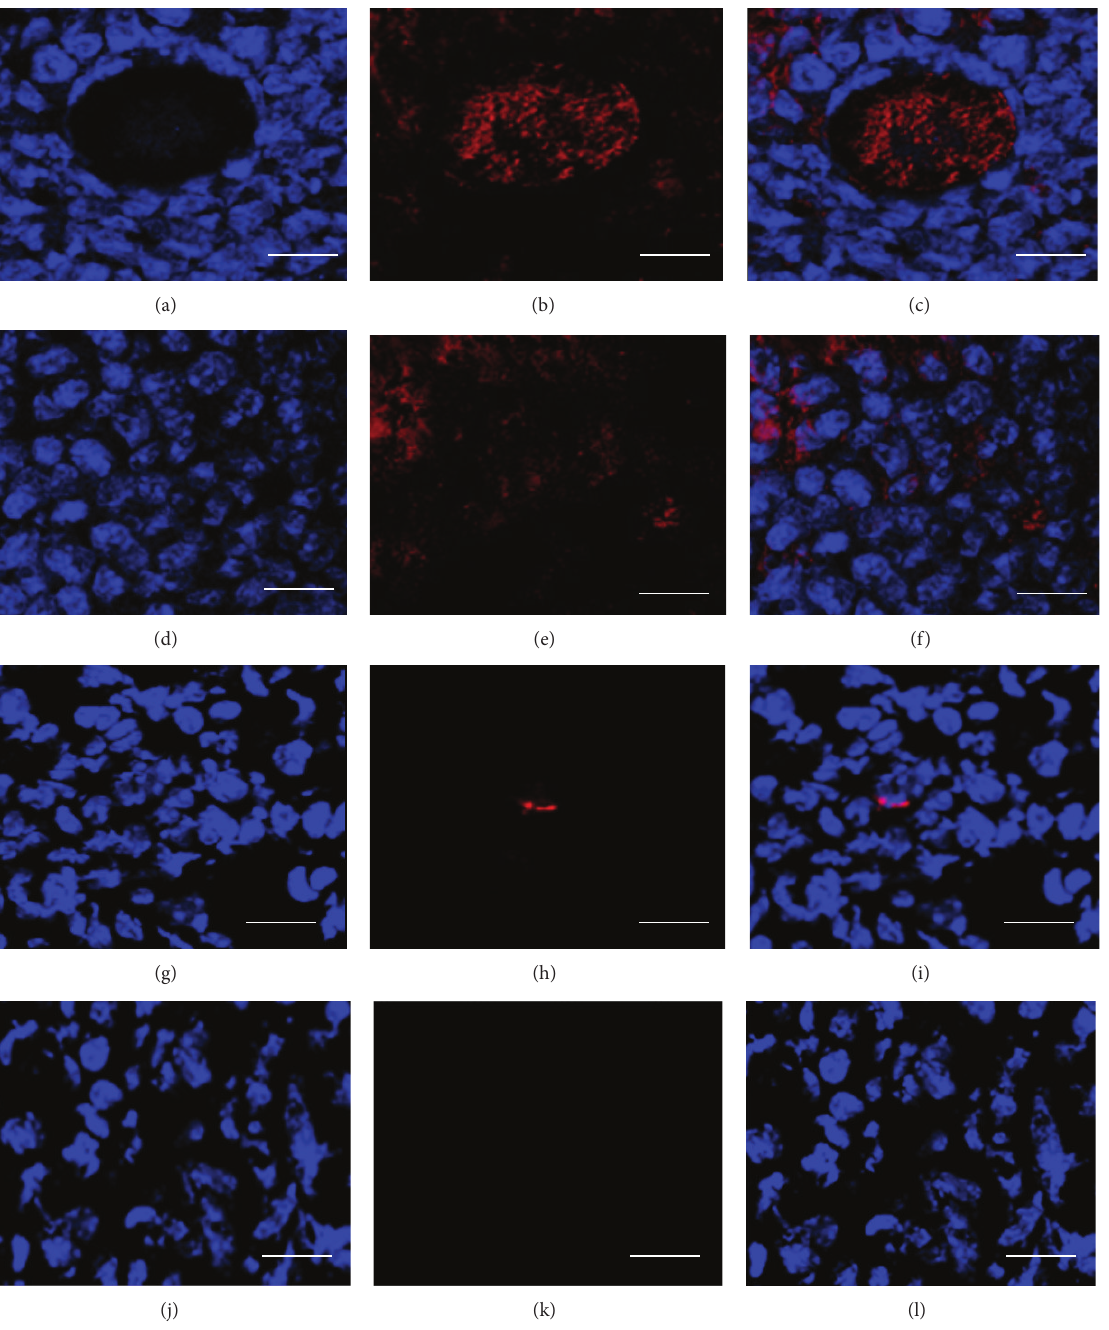
Figure 4: Fluorescence drugs accumulation in tumor tissue. In (RGD) 3 -tTF mice, (a) Hoechst 33258-stained nucleus (blue); (b) (RGD) 3 -tTF accumulated (red); merger of (a) and (b). In RGD mice, (d) Hoechst 33258-stained nucleus (blue); (e) RGD accumulated; (f) merger of (d) and (e). In TF mice, (g) Hoechst 33258-stained nucleus (blue); (h) no TF accumulation; (i) merger of (g) and (h) In saline mice, (j) Hoechst 33258-stained nucleus (blue); (k) no fluorescence; (l) merger of (j) and (k) (bar = 20 𝜇 m).